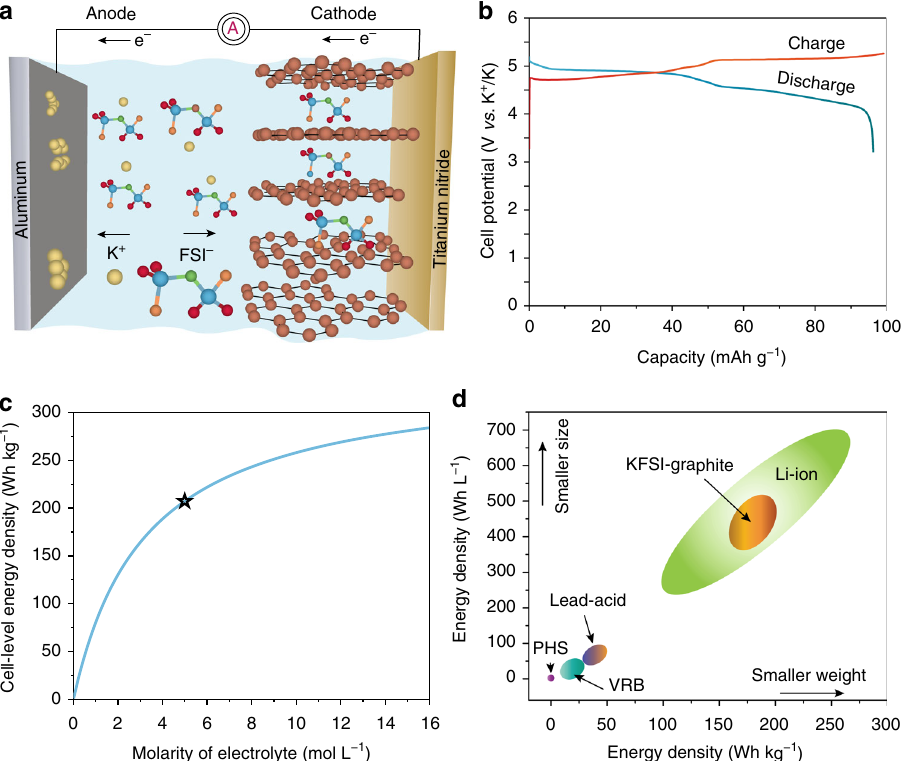
Fig. 1 Working principle and energy density of KFSI-graphite DIB. a Schematic of the charging process in KFSI-graphite DIB. Fluorine, oxygen, sulfur, and nitrogen atoms in the FSI − anion are shown in brown, red, blue, and green colors, respectively. b Typical galvanostatic voltage pro fi le of KFSI-graphite DIB measured at a current density of 50 mA g − 1 . c Calculated (curve from Eq. (4)) and experimental (single point) cell-level energy density of KFSI-graphite DIB using different KFSI concentrations in EC/DMC solvent. d Comparison of volumetric and gravimetric energy densities of KFSI-graphite DIB battery with other battery technologies: PHS, vanadium redox battery (VRB), lead acid battery, and Li-ion